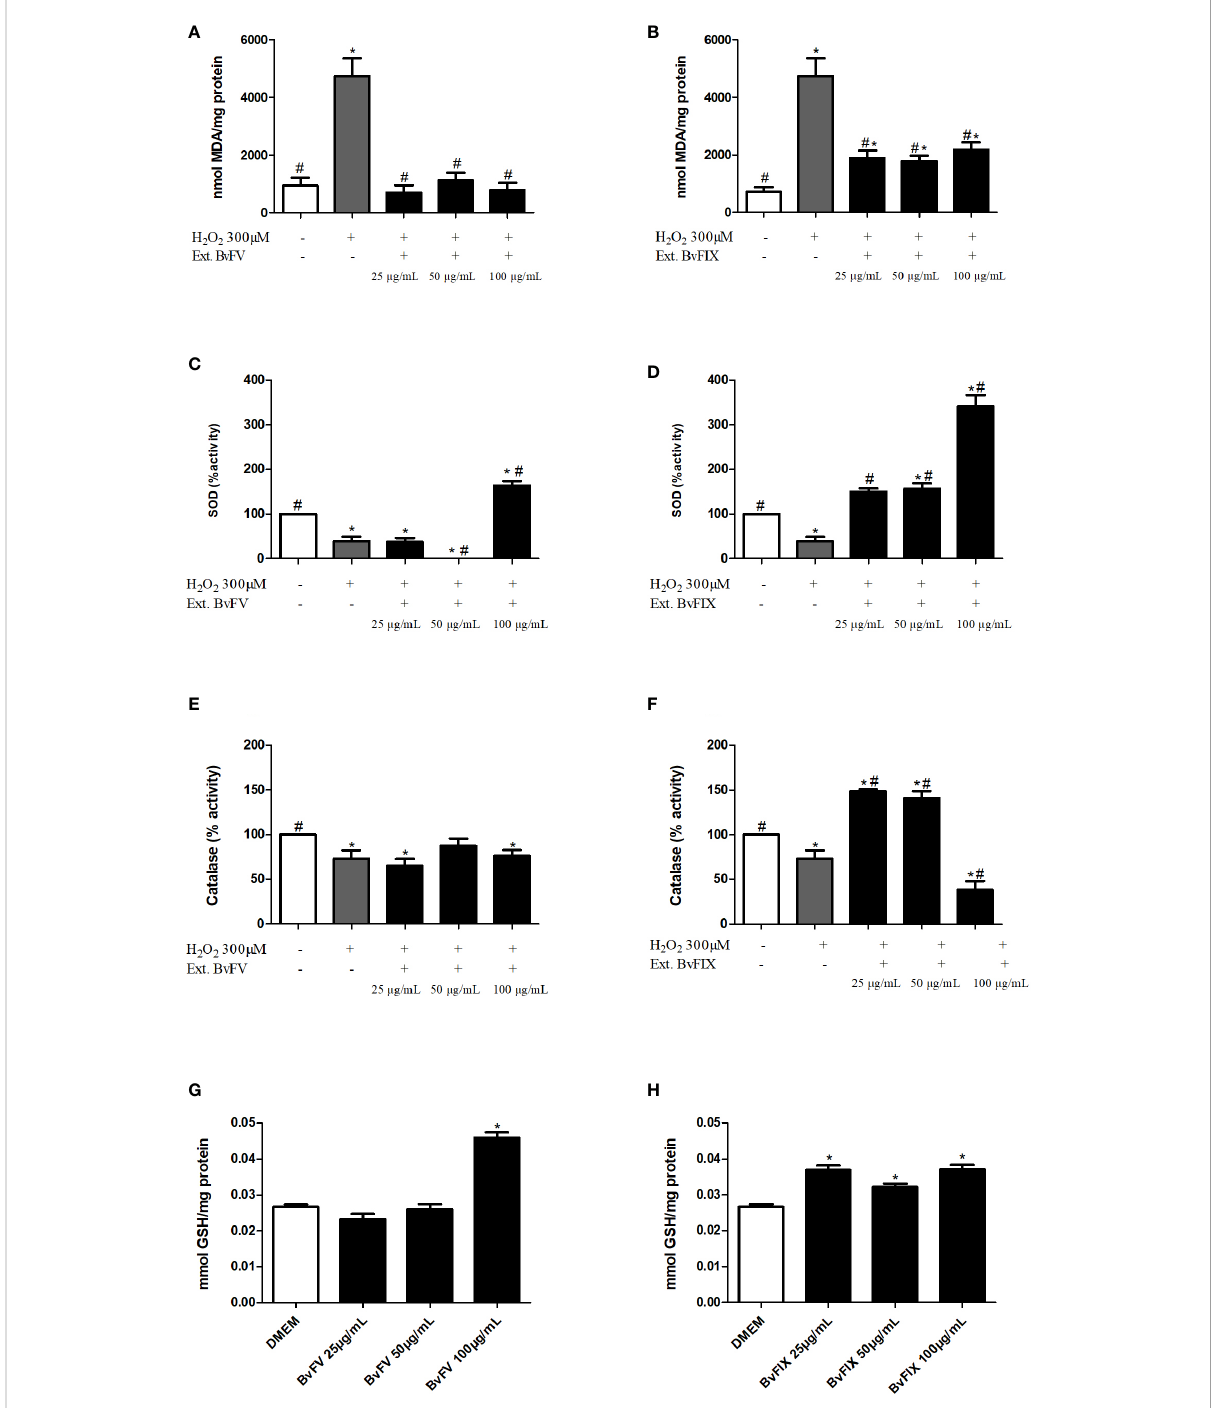
FIGURE 6 Assessment of antioxidant system in cells treated with fungal extracts. (A-F) Human dermal fi broblasts were treated for 48 h with different fungal extracts or only with the solvent used to solubilize the extracts (samples without extracts) and then inducted to oxidative stress by treatment with H 2 O 2 . (A, B) Results presented represent mean ± S.E.M of MDA concentration per mg of protein in cells treated or not with fungus extract: (A) BvFV, (B) BvFIX. (C, D) Results represent the mean ± S.E.M. of SOD enzyme activity: (C) BvFV, (D) BvFIX. (E, F) Results represent the mean